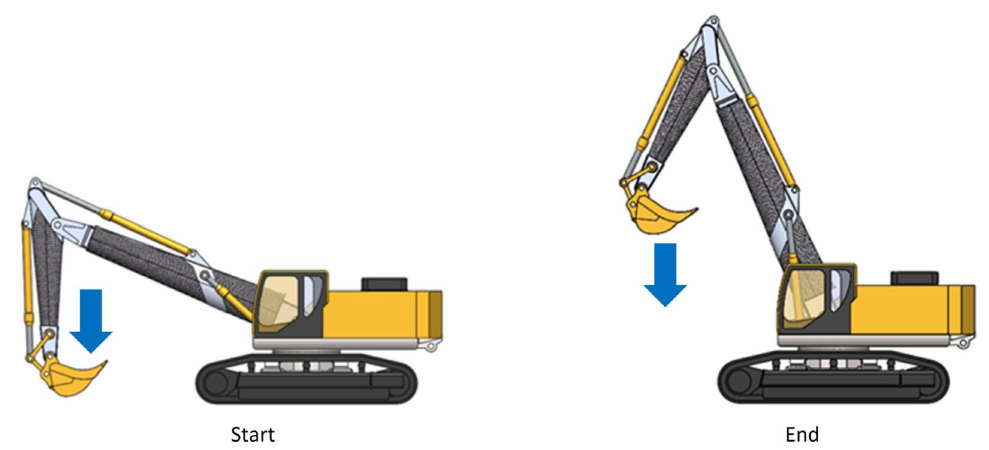
Figure 3. Load condition 2.